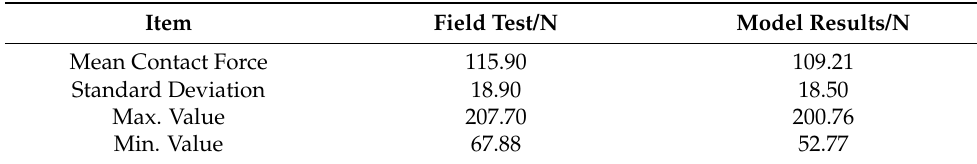
Figure 7. PC contact force. Table 2. PC contact force validation [28].